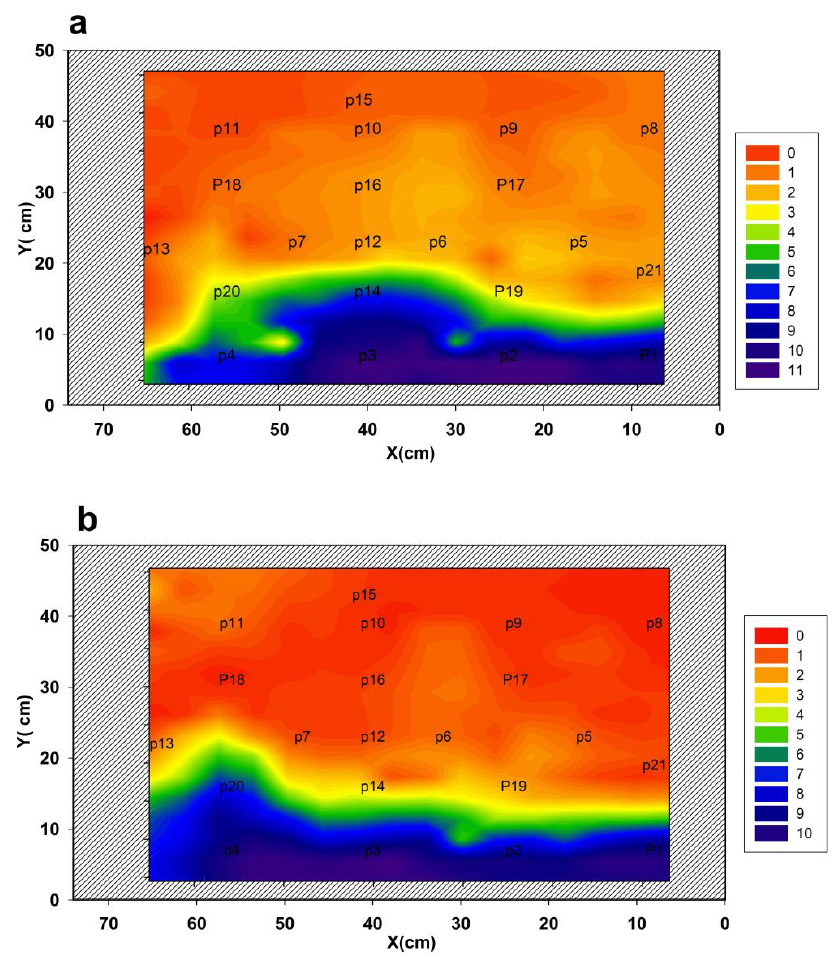
Figure 4. In ( a , b ) the moisture distribution maps of regions A and B of the tuff wall affected by capillary rise of water, are reported. The moisture level is shown as a gradient of color, red corresponds to the lowest water content, while dark blue corresponds to the highest water content In region A transverse relaxation time measurements were performed as a function of the height of the wall. After applying an inverse Laplace transformation to the magnetization decays measured with the Carr Purcell Meiboom Gill CPMG sequence, the distributions of transverse relaxation times were obtained, see Figure 5. In this representation, peaks represent the most probable T 2 values, whereas peak areas represent the population of each component. The distributions reported in Figure 5 indicate the presence of water confined in pores with various sizes.